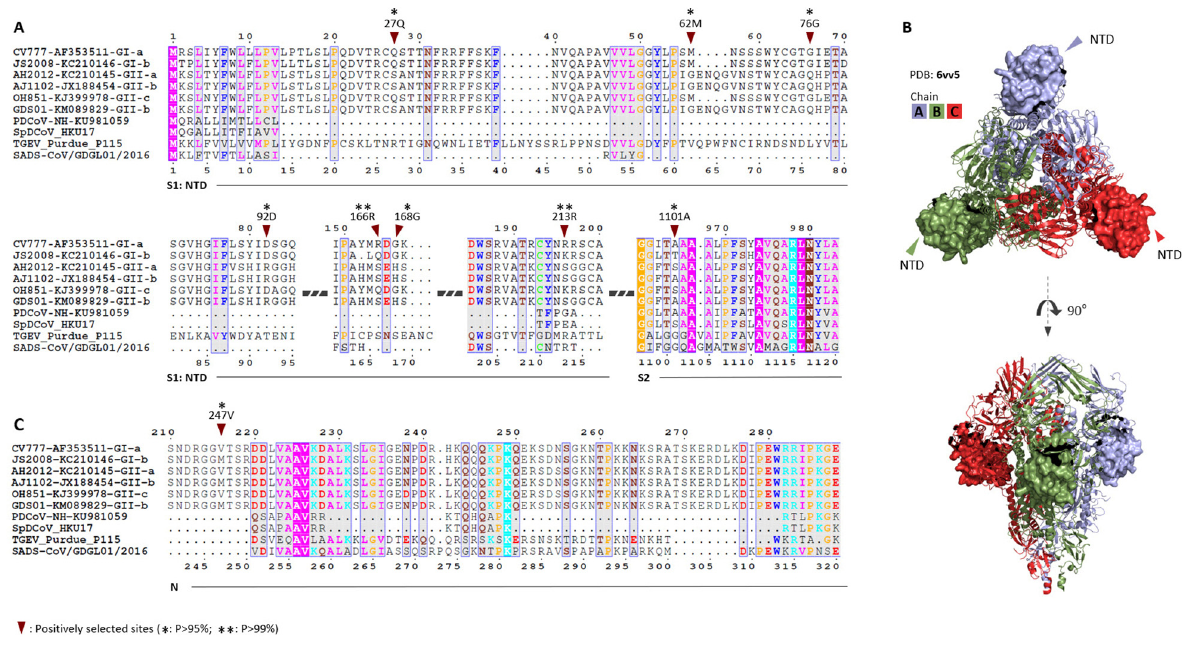
Figure 1. Selective pressures during the evolution of PEDV and related viruses: ( A ) eight positively selected sites in the spike (S) protein by NEB analysis, seven of them in the domain NTD, and one in the domain S2 (*: p > 95%; **: p > 99%); ( B ) the NTD domain in the surface of the S protein, showed as a surface model based on the PDB file 6vv5; ( C ) one positively selected site in the N protein by NEB analysis (*: p > 95%).